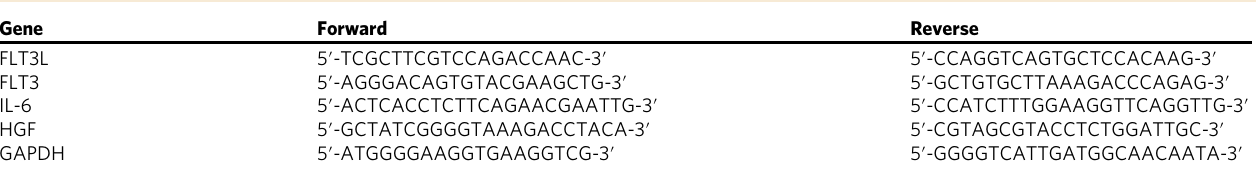
Table 3 Primers for real-time polymerase chain